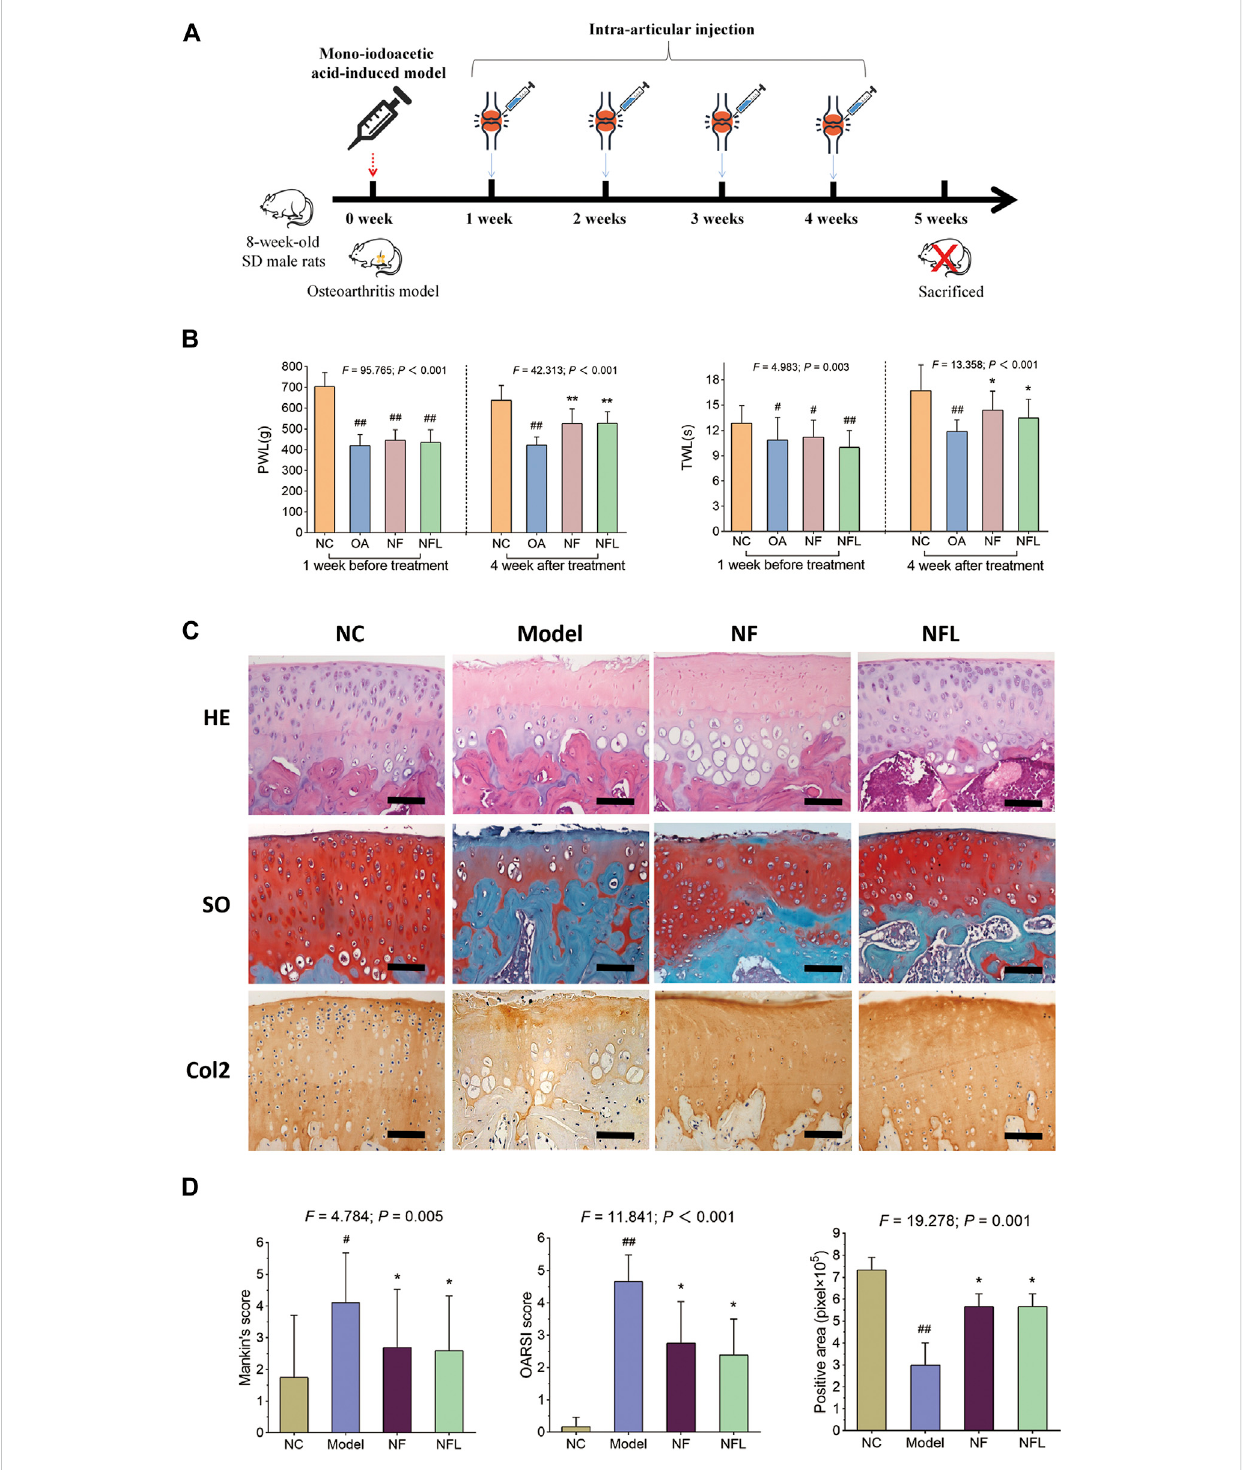
FIGURE 1 Study design of the animal experiment (A) ; pain behavior assessment (TWL and PWL) before and after treatment (B) ; histopathological observation on cartilage by HE and SO staining and immunohistochemical observation of Col2 expression (C) ; Quanti fi cation of Mankin ’ s and OARSI scores, and positive area of Col2 expression (D) . Values are shown as mean ± SD. # p < 0.05 or ## p < 0.01 vs . NC group; * p < 0.05 or ** p < 0.01 vs . Model group. NF, Nanofat. Scale bar = 100 μ